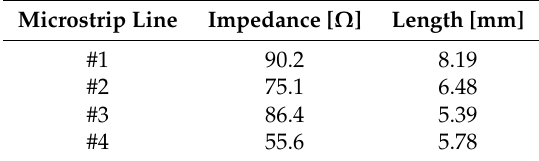
Figure 2. ( a ) Schematic of the feeding network in microstrip technology. By alternatively feeding the antenna at ports RHCP or LHCP, dual-CP operation mode is enabled. ( b ) Prototype of sequentially-fed patch antenna surrounded by a fence of passive monopoles and operating at f = 8.25 GHz. Table 1. Dual-circularly polarized (CP) single patch feeding network